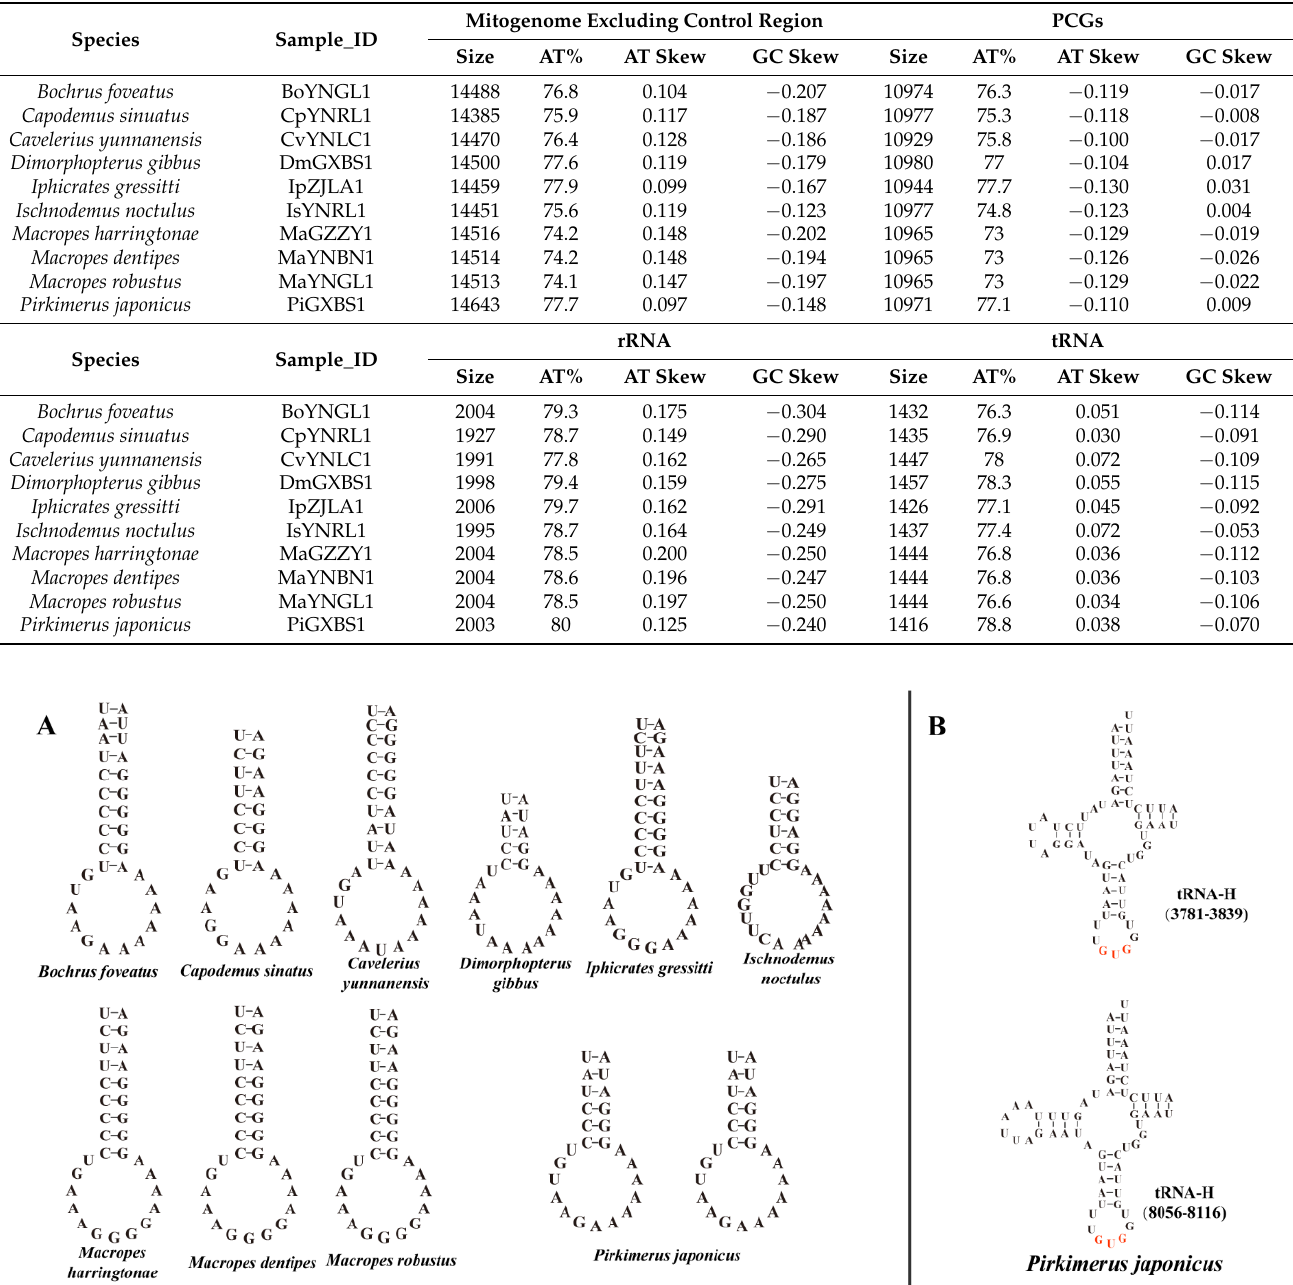
Table 1. AT-content, AT-, and GC-skew of 10 Blissidae mitochondrial genomes.